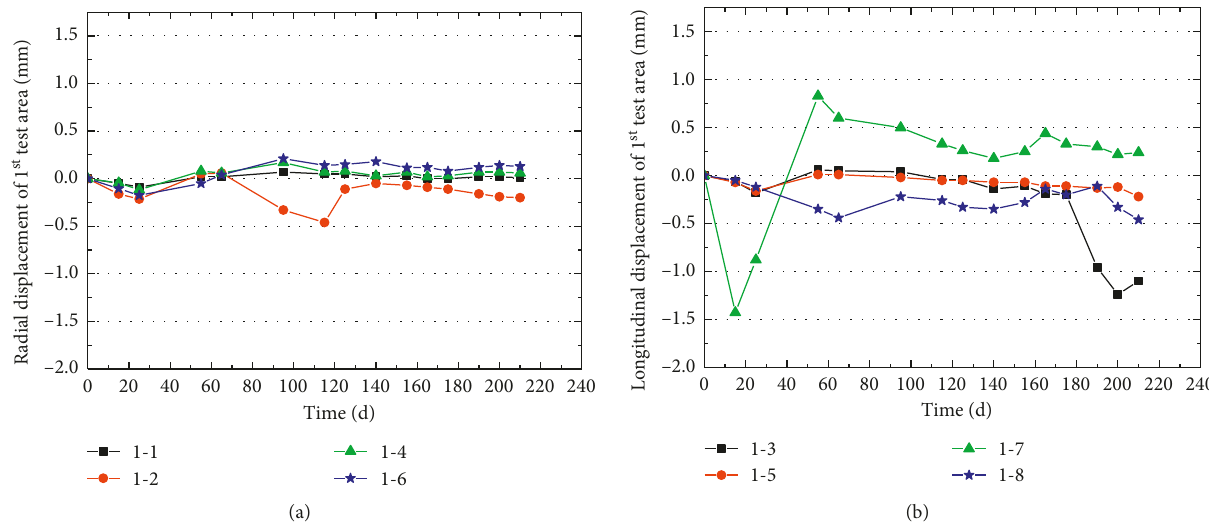
Figure 10: Radial and longitudinal displacement curves at the first test area ( − 280m). (a) Radial displacement; (b) longitudinal displacement.